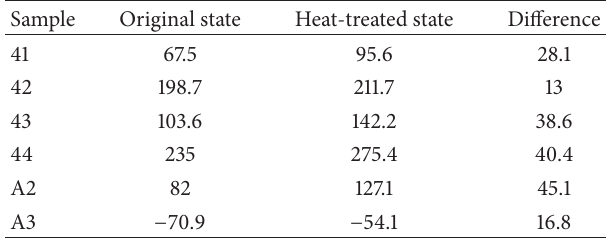
values of different rotor samples. 50